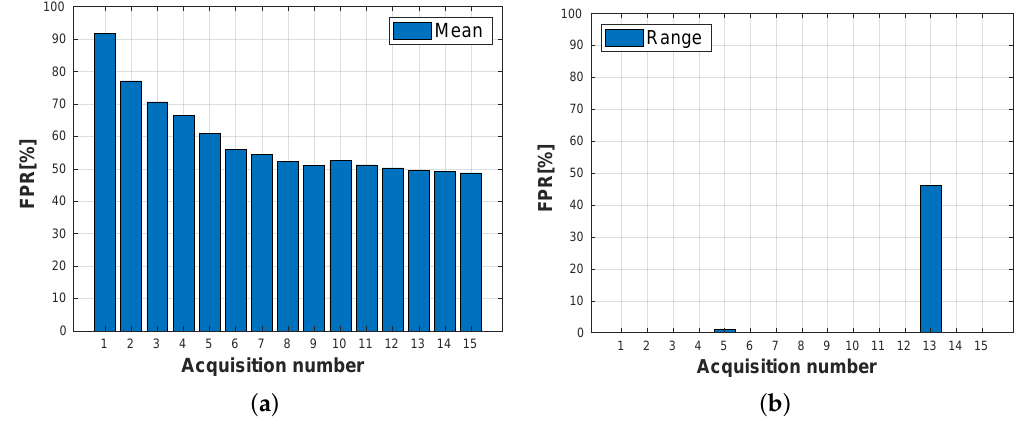
Figure 5. ( a ) The false positive rate (FPR), performing a leave-one-out test and using Bonferroni correction to account for multiple testing with the method described in [7]. ( b ) FPR obtained, performing a leave-one-out test and the Hannig-Marron global rejection threshold with the novel method proposed in this